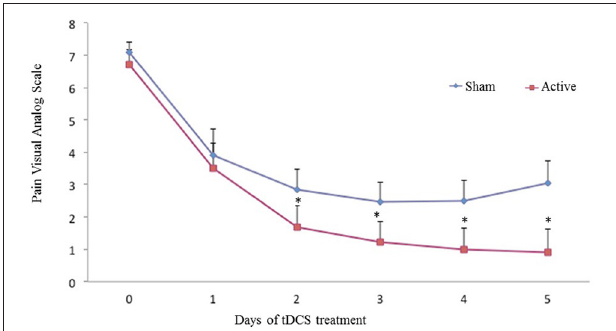
FIGURE 4 | Mean pain threshold at baseline and at the end of treatment. The error bars indicate the standard error of the mean (SEM). Asterisks ( * ) positioned above the symbols indicate significant differences ( p < 0.001